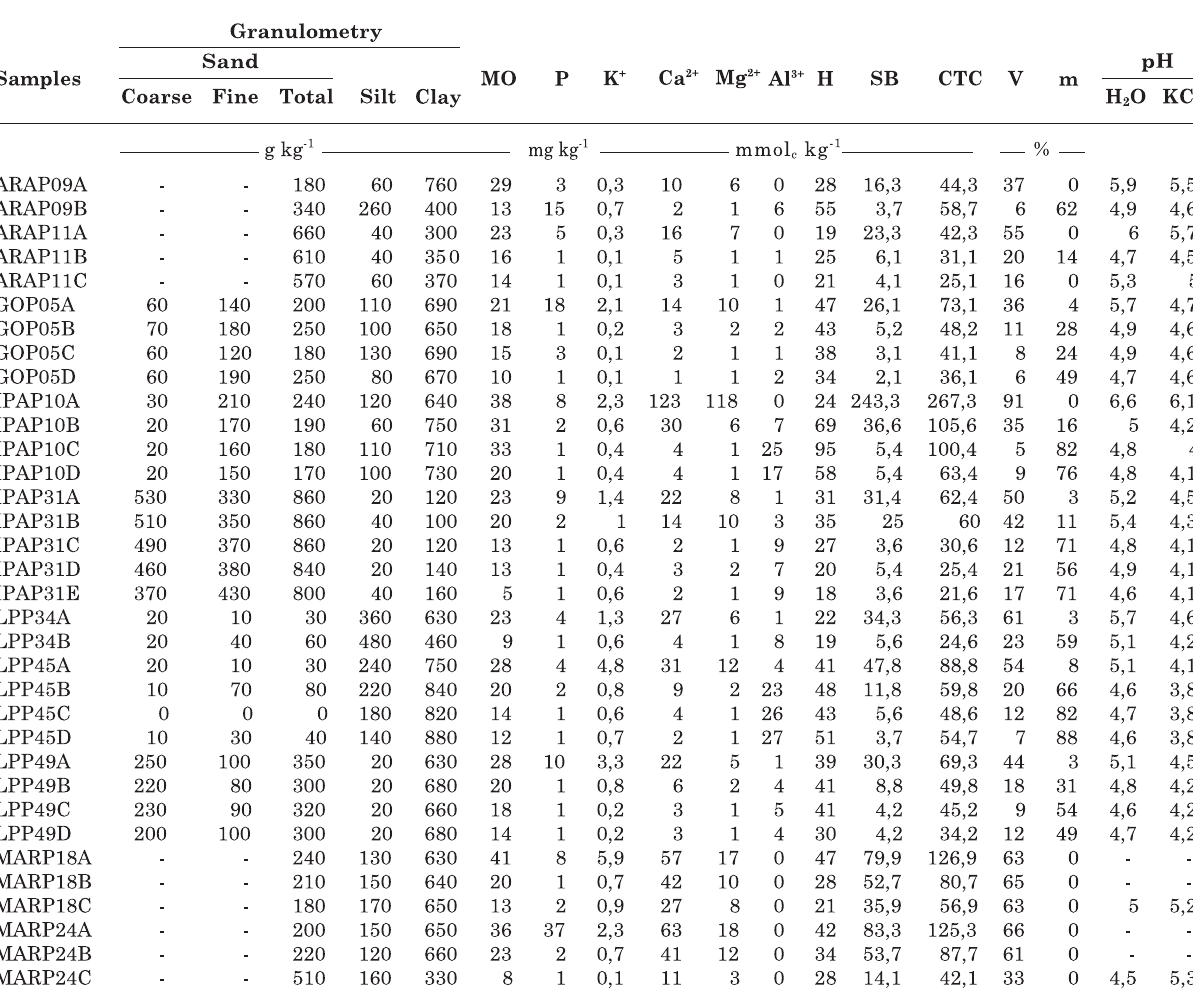
Table 1. Chemical and granulometrical analysis from soil profile samples ARAP09, ARAP11, GOP05, IPAP10, IPAP31,LPP34, MARP18 and MARP24, representing the Soil Spectral